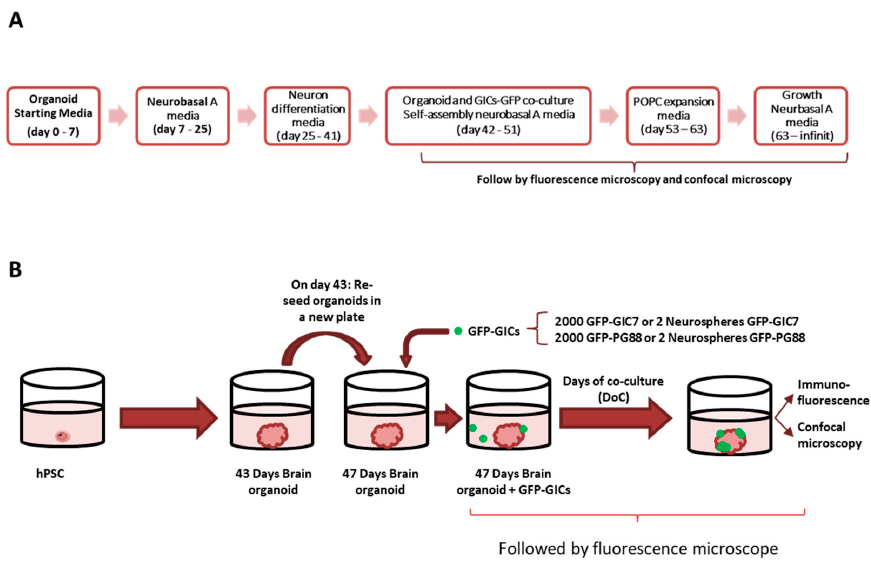
Figure 1. Schematic protocol of hiPSC cell cultures to induce neurocortical organoids and their co-culture with GFP-GICs. ( A ) Schematic protocol for neural induction of organoid cultures. The medium has been changed sequentially as indicated to obtain the different cell lineages. ( B ) On day 47, the GFP-GICs were seeded on top of the organoids to study their infiltration capacity on organoids. The obtained assembloid was followed by fluorescence microscopy until the end of the experiment when some of them were preserved for further histological analysis and confocal microscope imaging.